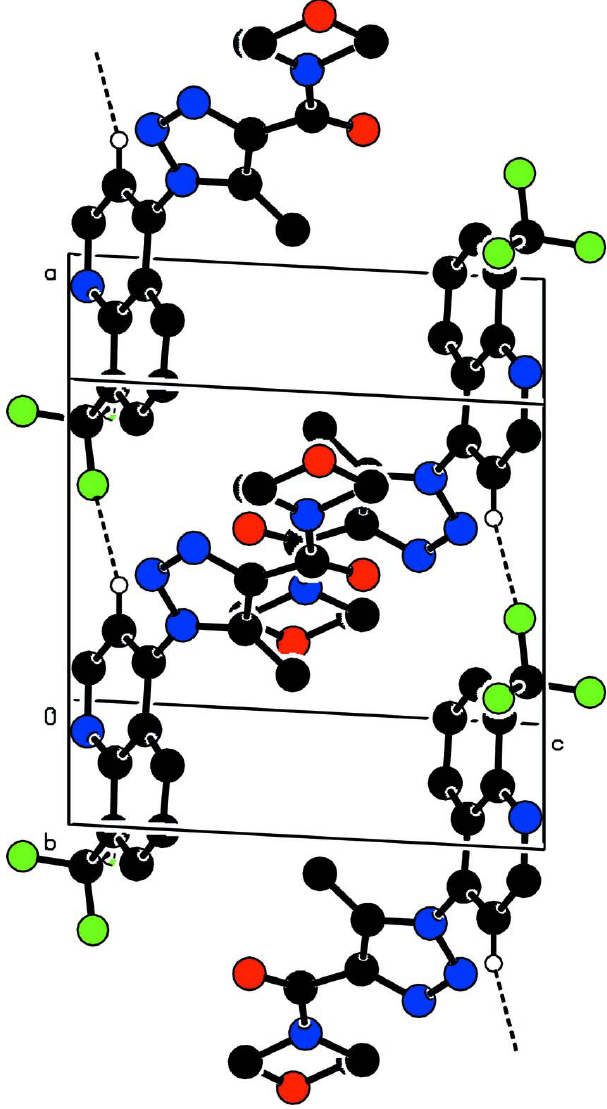
The packing of the title compound, viewed down the b axis. Dashed lines indicate hydrogen bonds. H atoms not involved in hydrogen bonding have been omitted. Only the major component is